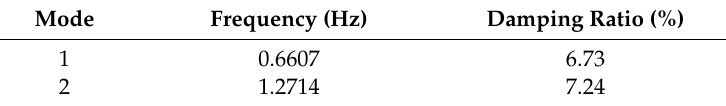
Table 3. Oscillation parameters of DC voltage.